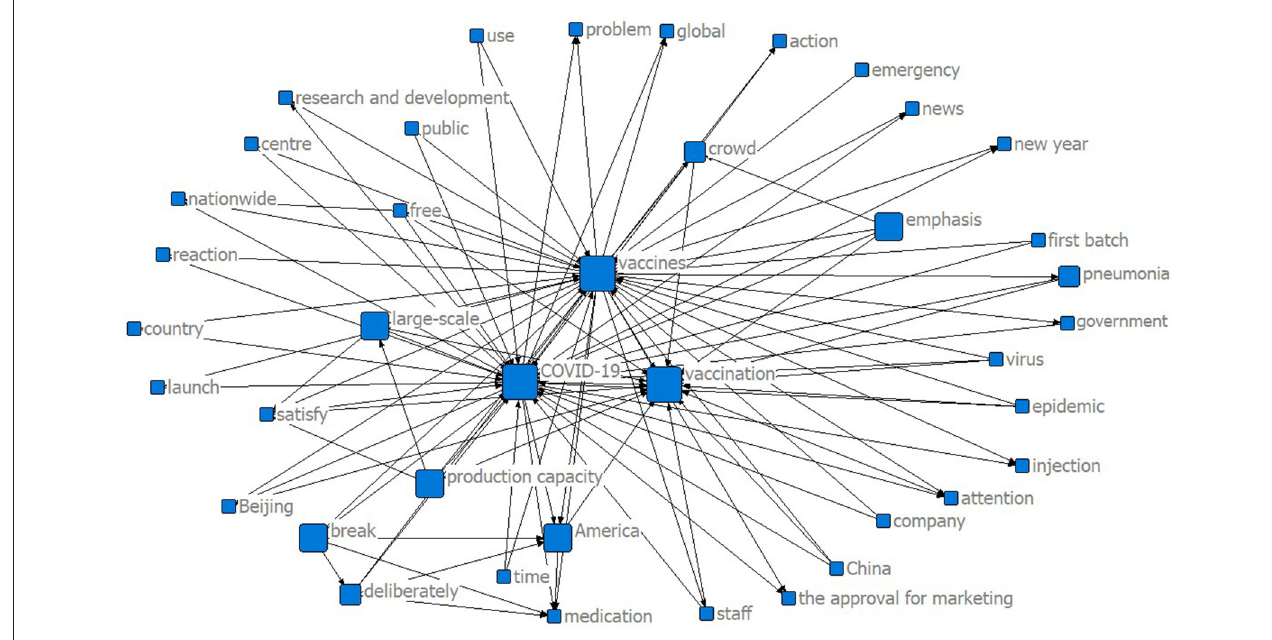
FIGURE 3 | Semantic network graph of domestic COVID-19 vaccines after approved for marketing.